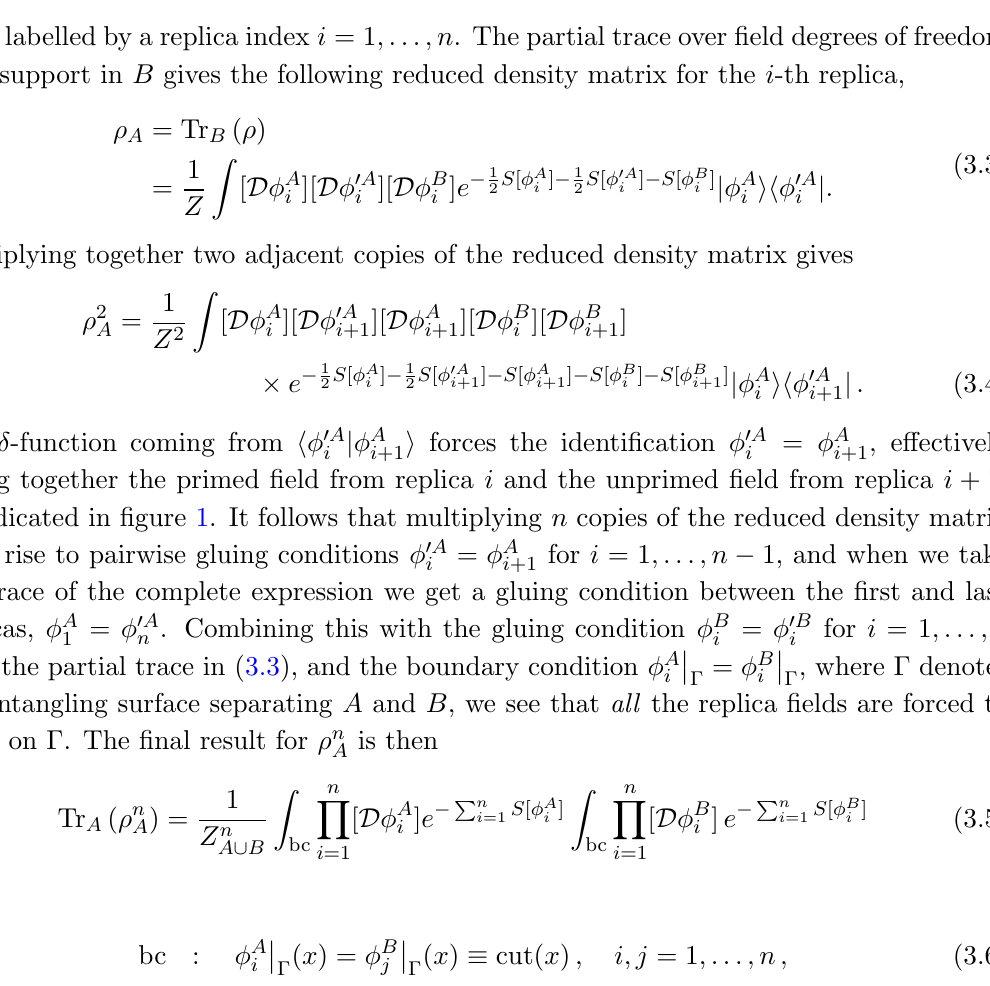
Figure 1 . The gluing procedure due to the replica trick. Gluing due to the partial trace over B is represented in red, due to multiplication of the reduced density matrices (cid:26) A in blue, and due to the (cid:12)nal total trace in